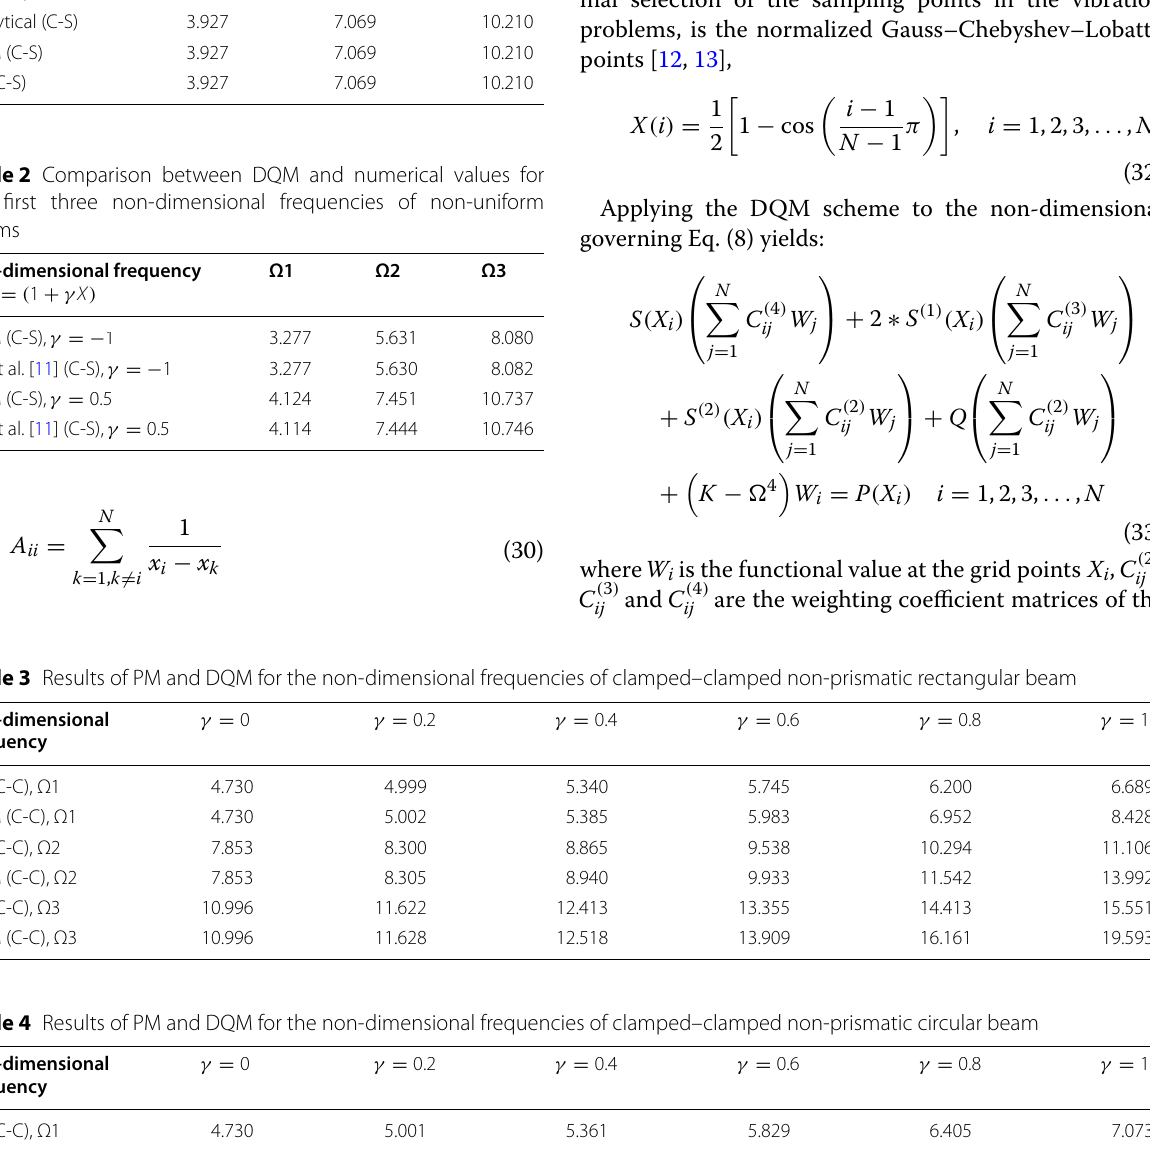
For calculating the weighting coefficients of m th order The accuracy of DQM is affected by choosing of the number, N , and type of the sampling points, x i . The opti- mal selection of the sampling points in the vibration problems, is the normalized Gauss–Chebyshev–Lobatto points [12, 13],